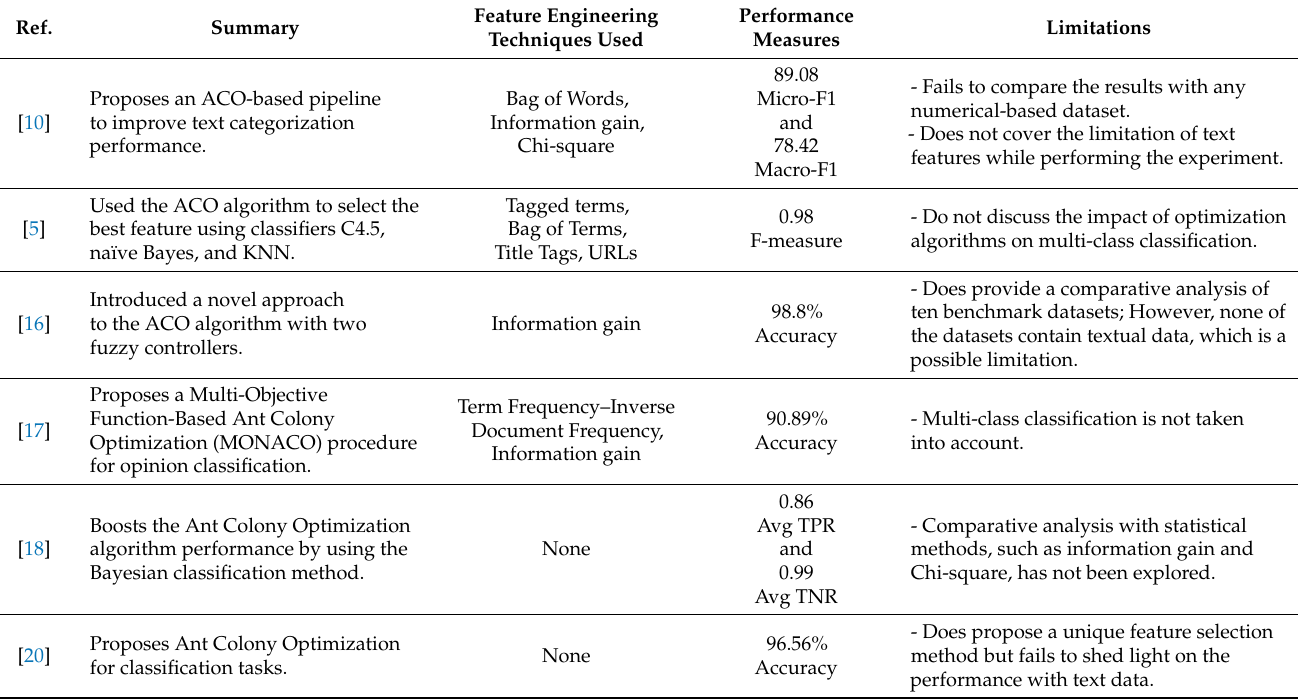
Table 1. Relevant research papers studied in the literature review from different